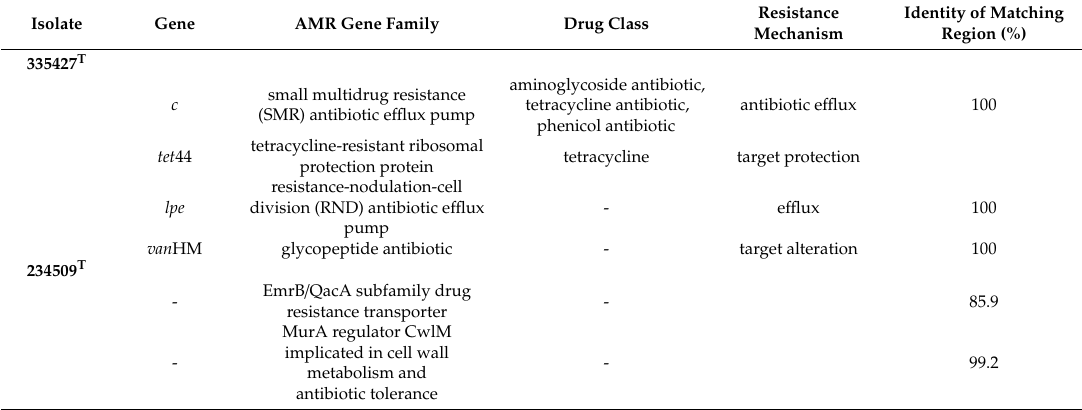
Table 4. Antimicrobial gene resistance genes in the genomes of isolates 335427 T and 234509 T . Resistance Identity of Matching Isolate Gene AMR Gene Family Drug Class Mechanism Region (%) 335427 T aminoglycoside antibiotic, c small multidrug resistance tetracycline antibiotic, (SMR) antibiotic e ffl ux pump